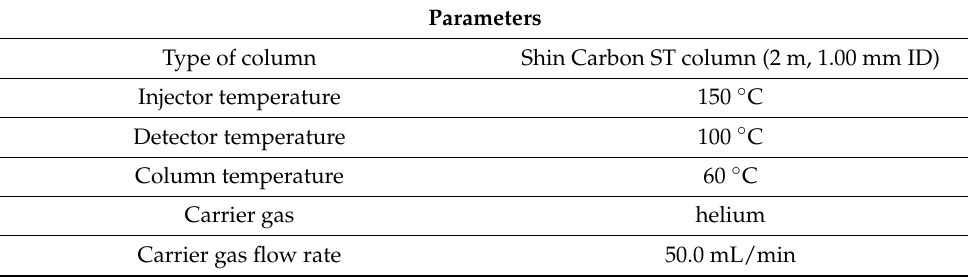
Table 4. Parameters of chromatographic